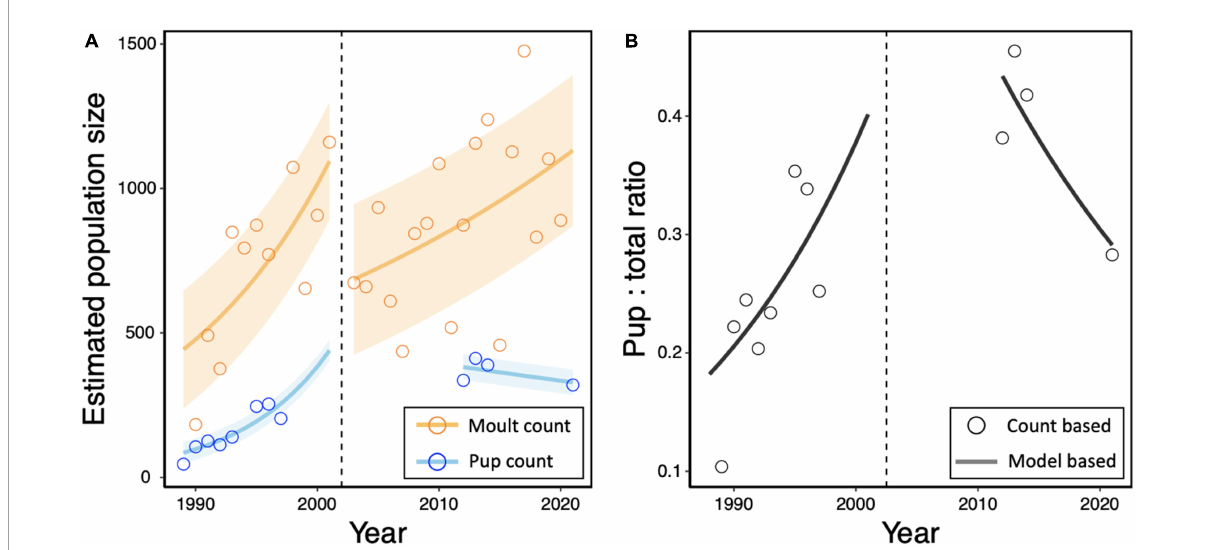
FIGURE6 (A) Estimates for total population size of harbour seals in the Koster archipelago are based on August moult counts adjusted for a 65% haul-out rate (orange points). The cumulative maximum number of pups during June pup counts from historical telescope surveys and zoom-video surveys in 2021 were taken to represent 100% of pups (blue points). Separate exponential models were fit to count data for total population size (orange line) and pup numbers (blue line) before and after the year of mass mortality due to Phocine distemper virus (PDV) (dashed line). Shaded regions represent the residual standard error for each model. (B) The ratio of pups to estimated total population is given for annual pup counts (points) and based on the exponential model